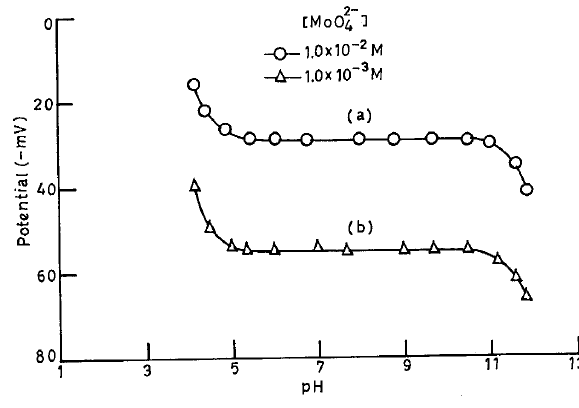
Figure 2. Effect of pH on cell potential; [MoO 42- ]=1.0 × 10 -2 M (a) and 1.0 × 10 -3 M (b) for sensor no.